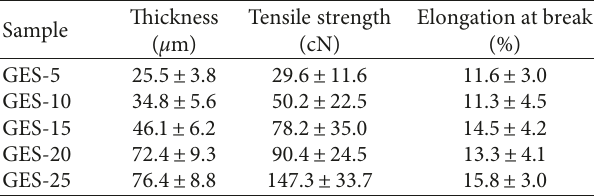
Figure 4: SEM images with 500 × and 2000 × magnification and the measured fiber-diameter distribution of (a) GES-5, (b) GES-10, (c) GES- 15, (d) GES-20, and (e) GES-25. Table 1: Thickness and mechanical properties of GES products.